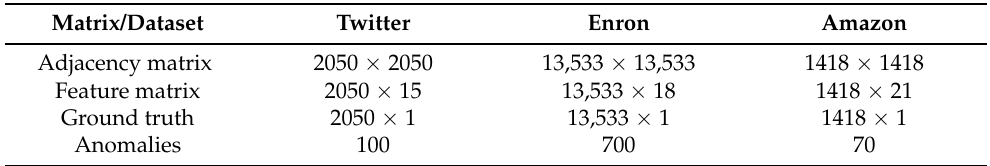
Table 1. Summary Statistics for the